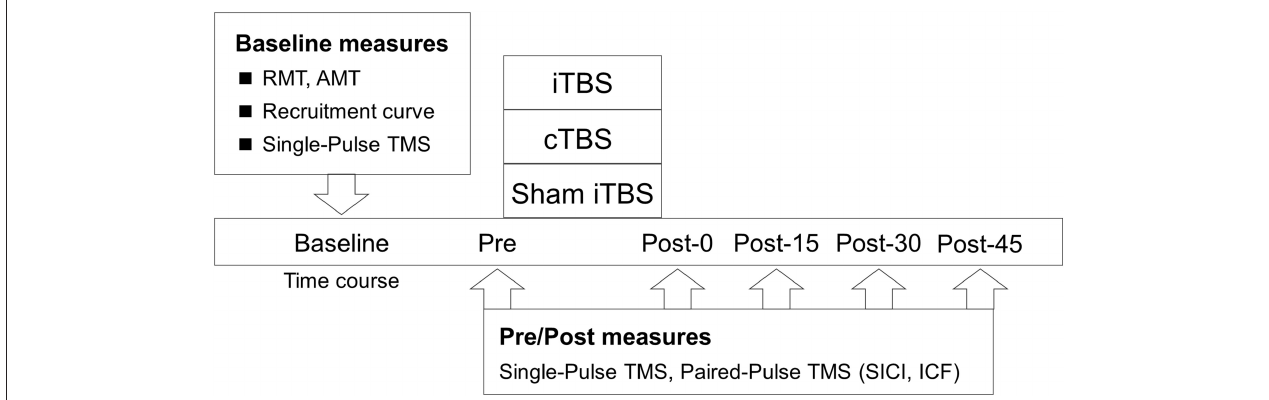
FIGURE 1 | Experimental procedure. The participants received iTBS, cTBS, and sham iTBS randomly at intervals of over 3 days. The resting motor threshold (RMT), active motor threshold (AMT), recruitment curve, and single-pulse TMS were assessed at the baseline. Single- and paired-pulse TMS were assessed before TBS (Pre) and at 0 (Post-0), 15 (Post-15), 30 (Post-30), and 45min (Post-45) after